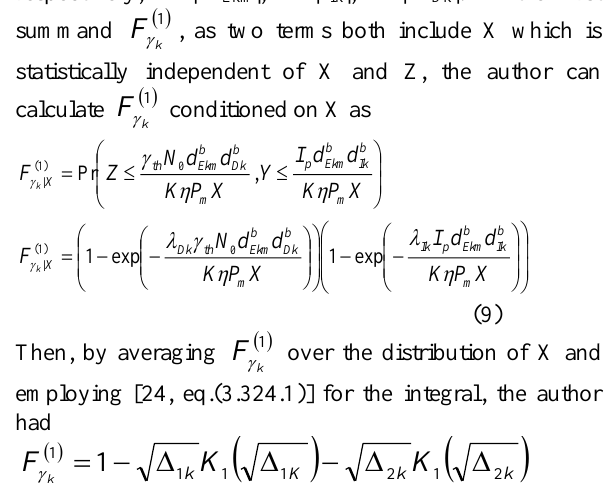
Fig. 11. OP versus b: K=3, K=4, (x PU , y PU )